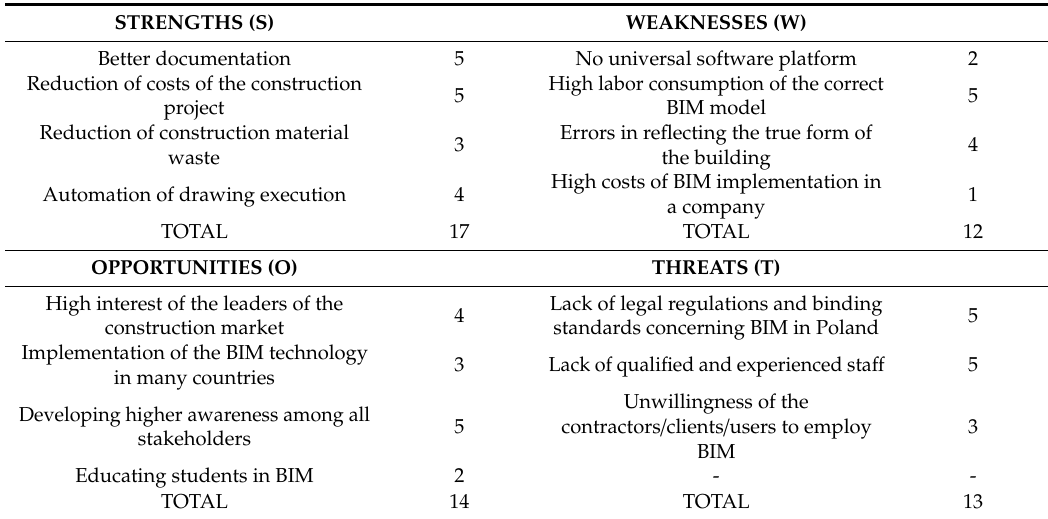
Strengths and weaknesses, as well as opportunities and threats of BIM technology implementation in Polish construction projects (own